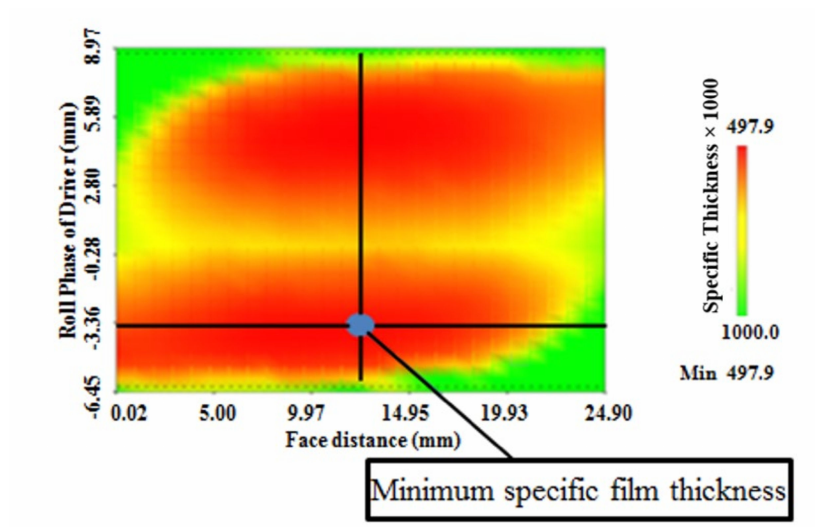
Figure 10. Specific film thickness of pinion for distance of pulling up equal to 0 mm.